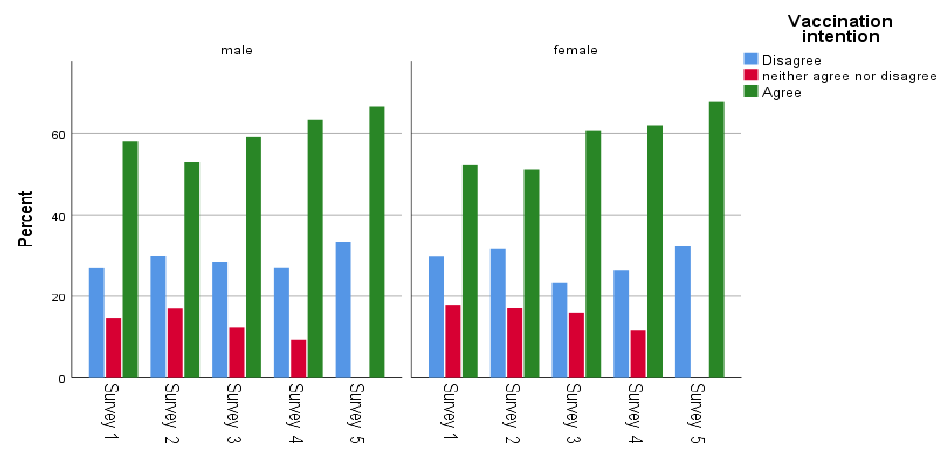
Figure 3. Gender and vaccination intention across the surveys.